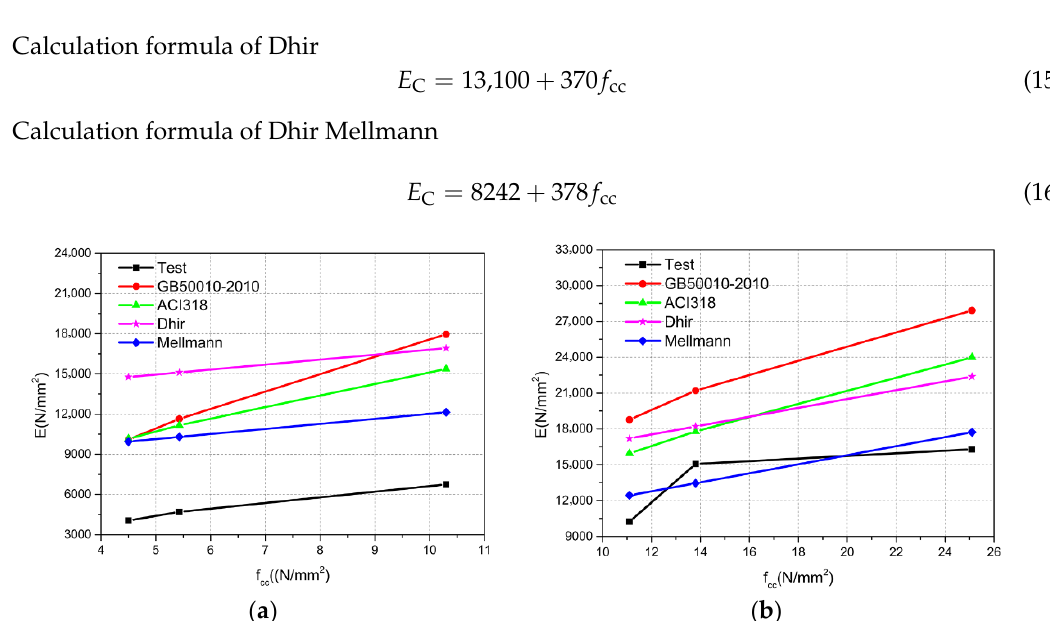
Figure 16. Modulus of elasticity from the test and results from each formula. ( a ) Group A; ( b ) Group AD.